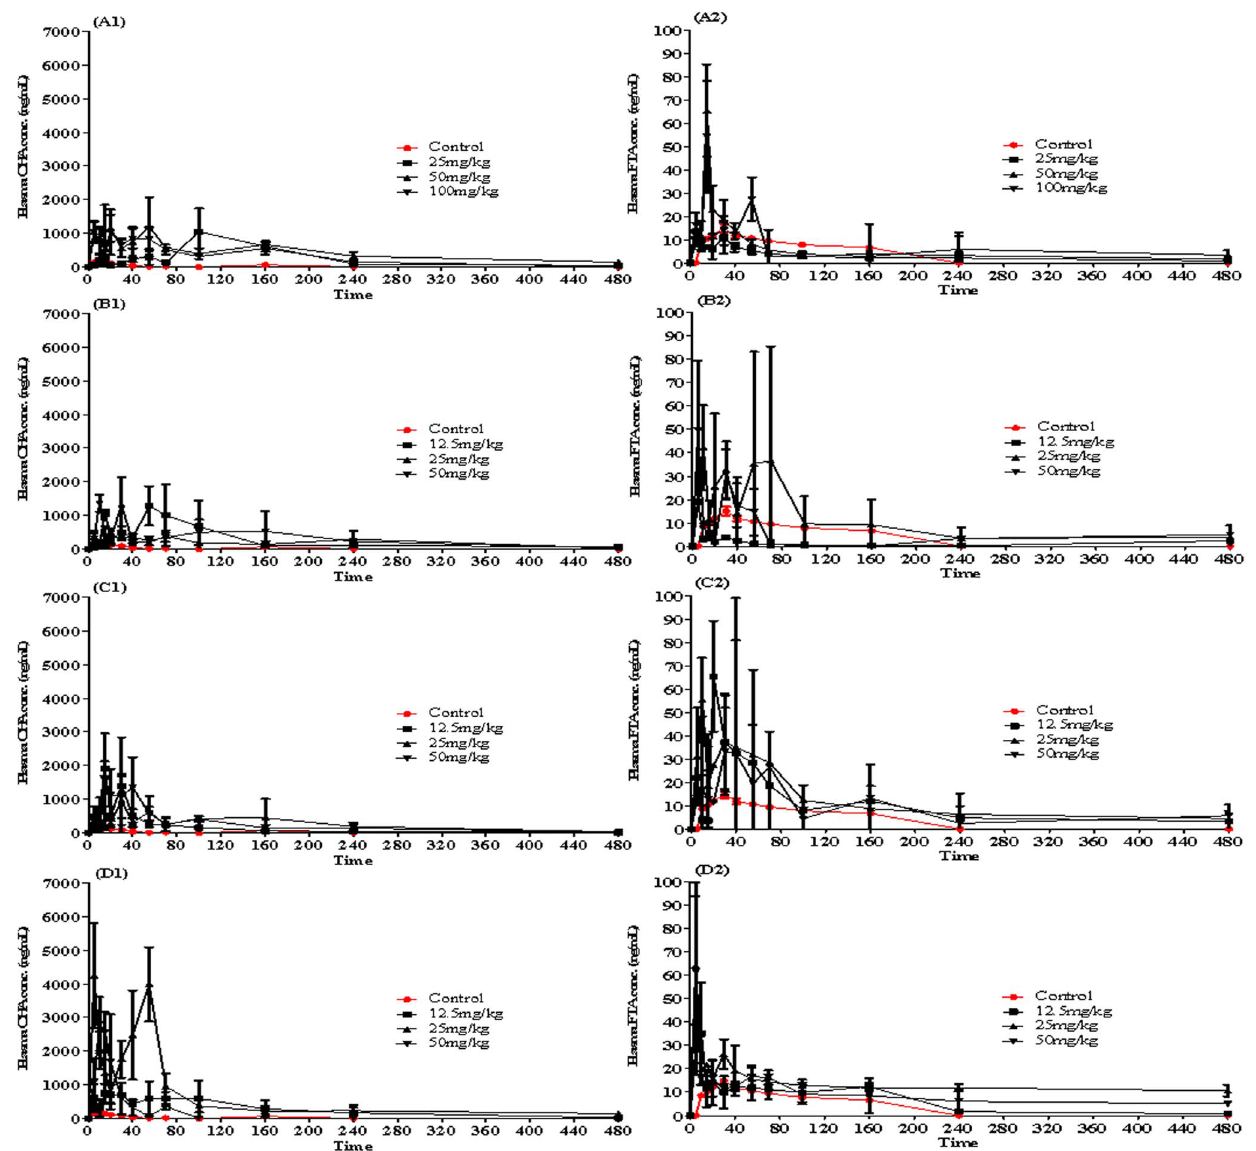
Figure 5. Plasma concentration-time profiles of FTA (A2, B2, C2 and D2) and CHA (A1, B1, C1 and D1) with CMCs and COS after administration to the rat gastrointestine by invivo pharmacokinetics study. Results are expressed as the mean 6 S.D. of 3–5 experiments (A1, A2: HCMC; B1, B2: MCMC; C1, C2: LCMC; D1, D2: COS).